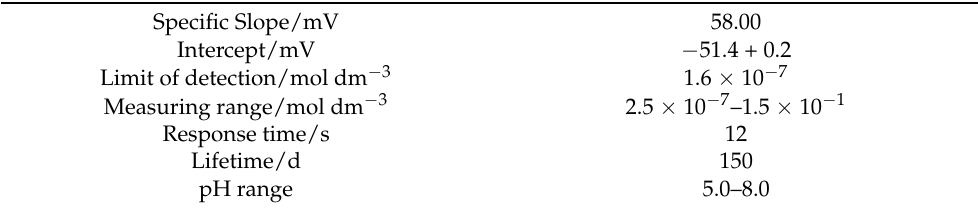
Table 1. Analytical validations of the developed Al 3+ electrode matrix